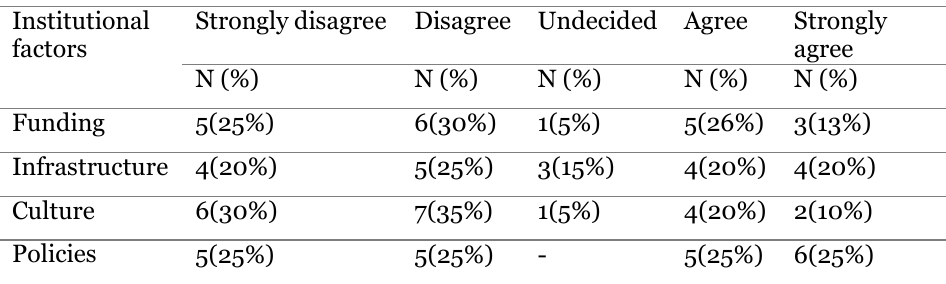
Institutional Factors That Determine E-Learning